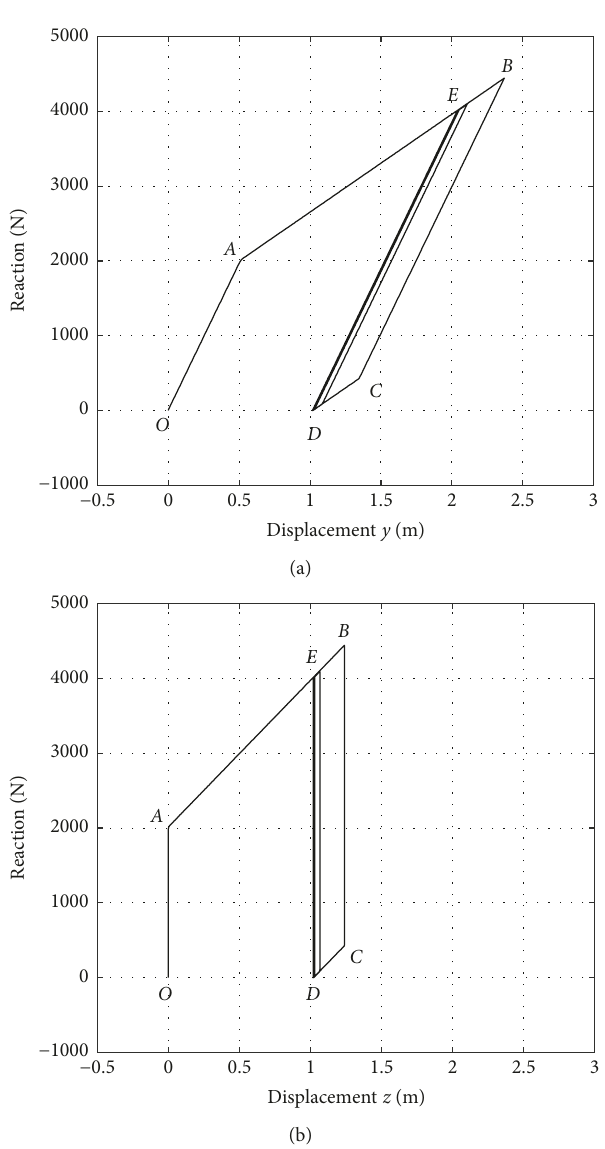
Figure 17: Hysteretic loops in elastoplastic system: relationships (𝑅,𝑦) (a) and (𝑅,𝑧)